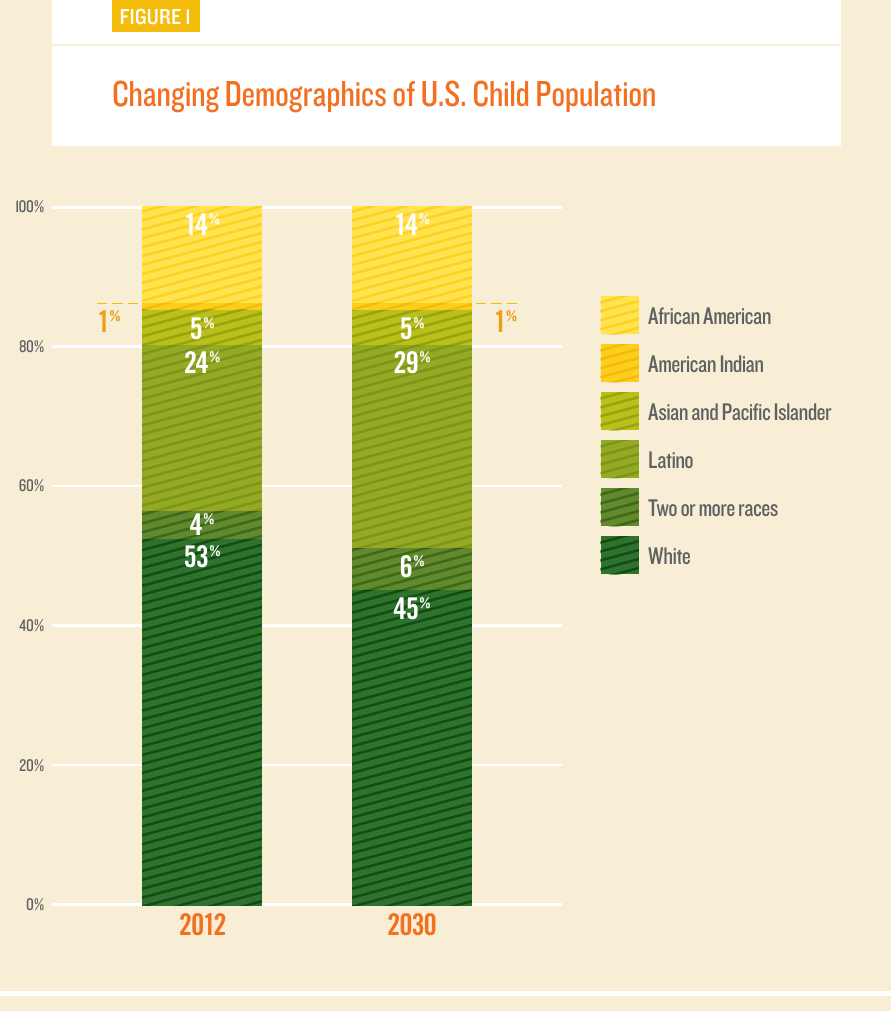
The Annie E. Casey Foundation |